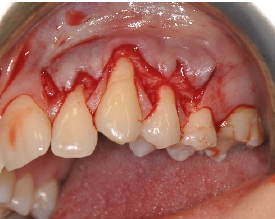
Figure 4. Trapezoidal flap after vertical releasing incisions.